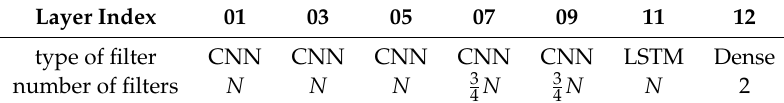
Figure 7. A boxplot of the AUCs of different DNN architectures. For the LSTM architecture, at least two LSTM layers were involved, while for the ConvLSTM architecture, only one LSTM layer was involved. The dataset was split at ( a ) the subject level and ( b ) the sample level. Table 3. The ConvLSTM architecture (ConvLSTM is our proposed model that combines convolutional and recurrent models). To keep the architecture clear, we omitted the input layer (layer 00) and the dropout layers (the even layer indices) applied after each convolutional neural network (CNN) layer. N was set to 128.